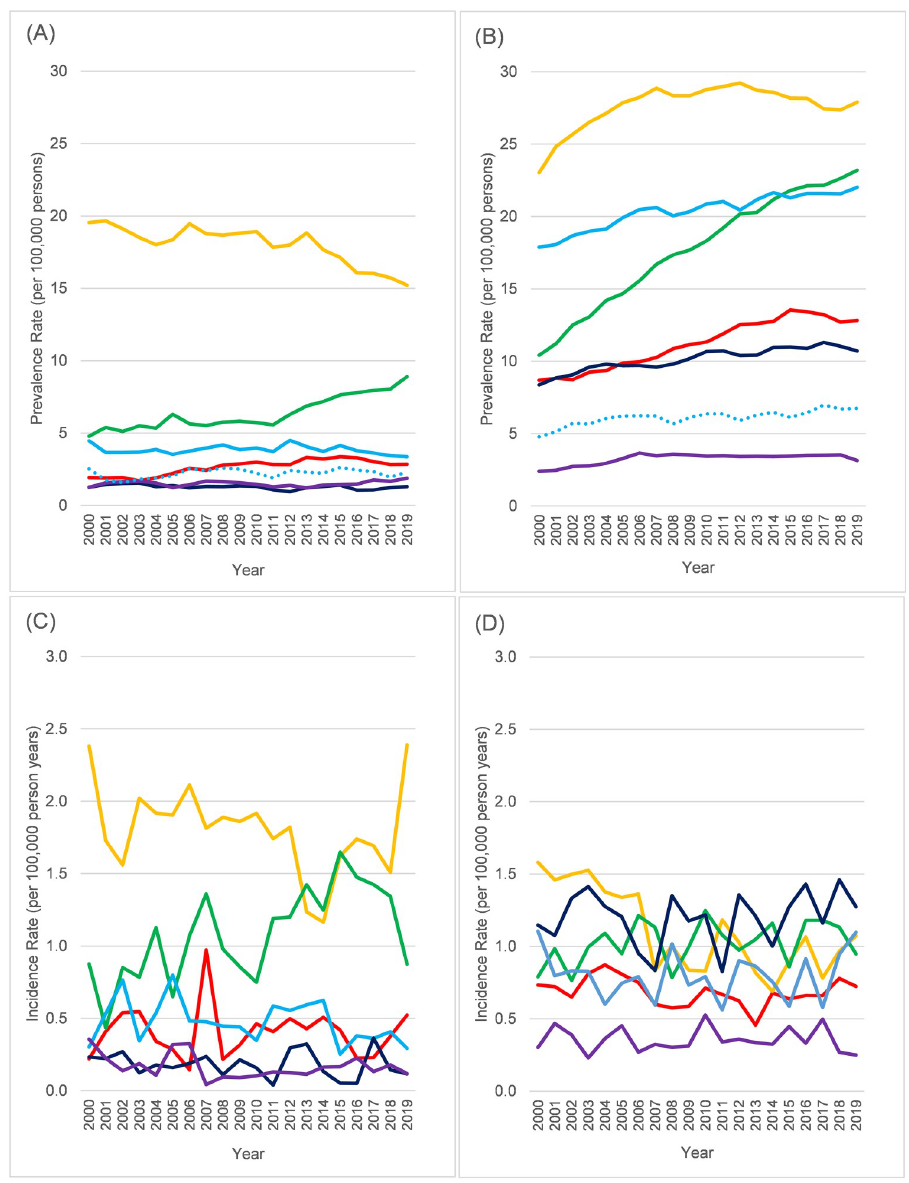
Fig 5. Time trends in neuromuscular disease 2000–2019 by selected condition, ages 0–44 only. (A) Prevalence in ages 0–14 years. (B) Prevalence in ages 15–44. (C) Incidence in ages 0–14 years. (D) Incidence in ages 15–44 years. Red = Inflammatory myopathies, Orange = Muscular dystrophies, Green = Charcot-Marie Tooth disease, Light Blue = Guillain-Barre´ syndrome, Dark Blue = Myasthenia gravis, Purple = Motor neurone disease. Solid lines = Lifetime, Dotted lines = excluding Guillain-Barre´ syndrome codes not recorded in last 5 years. All rates age standardised (within age-group) to CPRD population as of